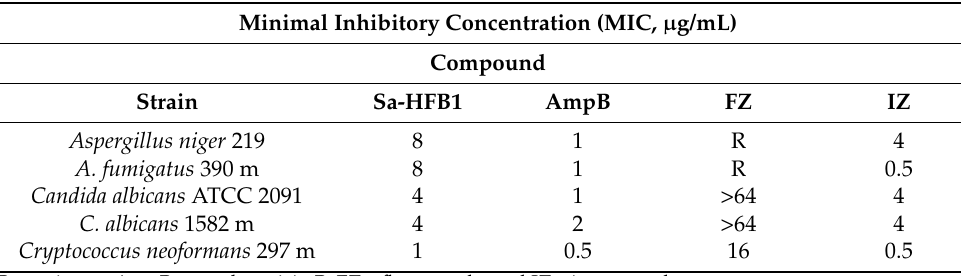
Table 2. Minimal inhibitory concentration of Sa-HFB1 compared with target antifungal drugs. Minimal Inhibitory Concentration (MIC, µ g/mL) Compound Strain Sa-HFB1 AmpB FZ